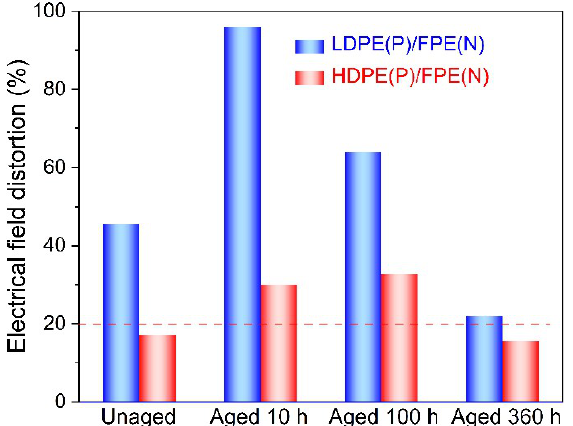
Figure 17. Electric field distortion of double-layer samples polarized for 40 min under − 50